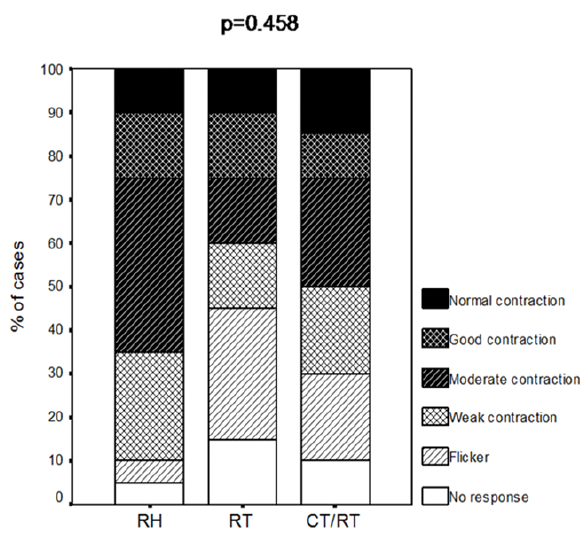
Figure 3 - Distribution of pelvic floor muscles contraction (Oxford scale) according to treatment